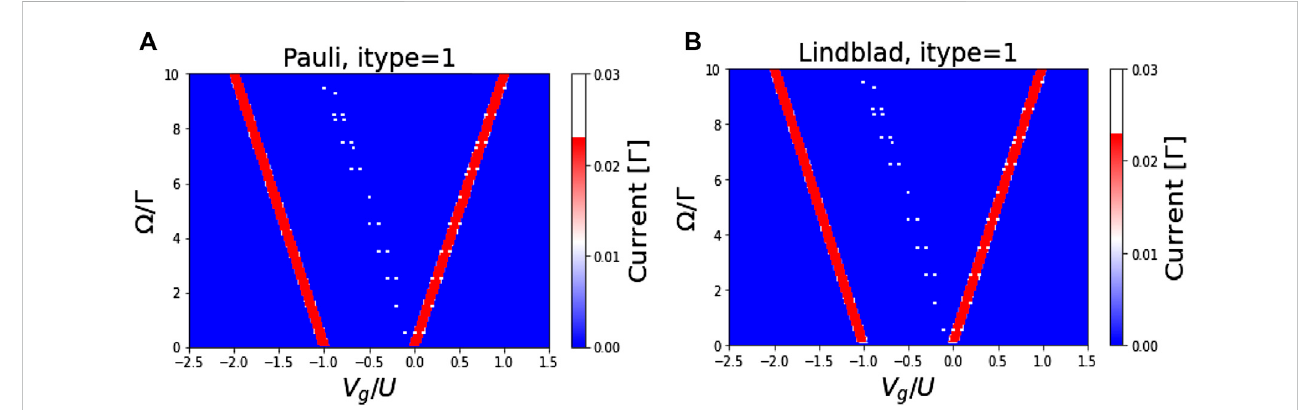
FIGURE 5 Tunnelling current obtained from different quantum master equations in the spinful single orbital quantum dot model showing the dependence of predicted Pauli (A) and Lindblad (B) tunnelling current on gate voltage and on strength of the orbital